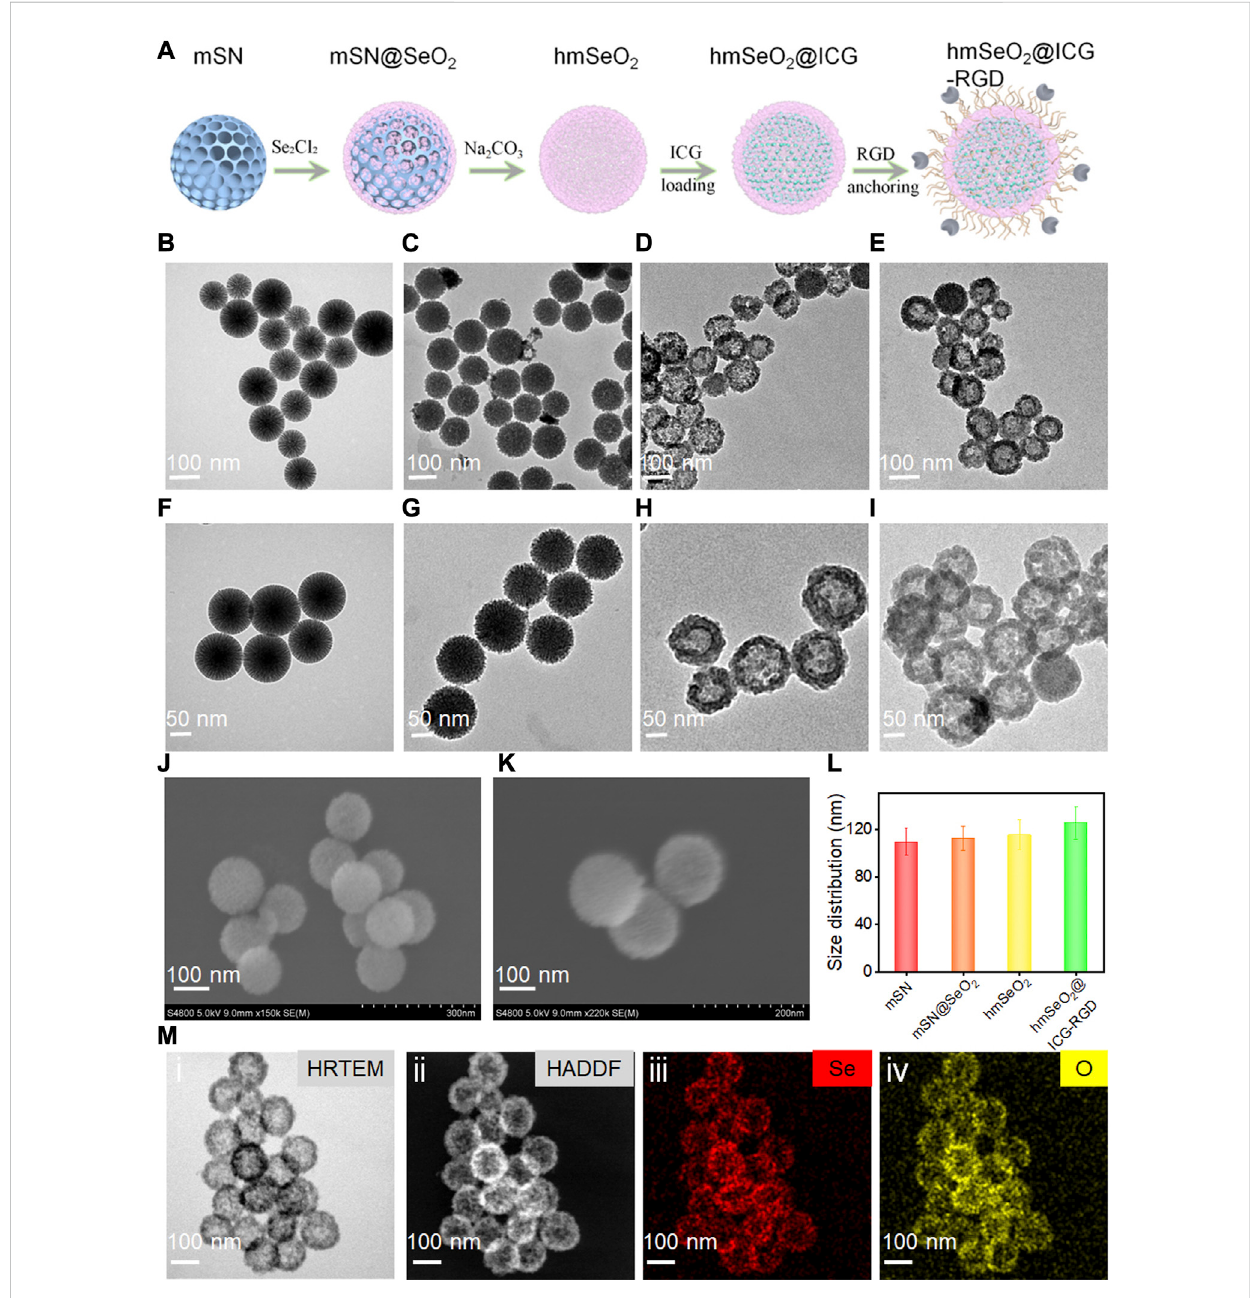
FIGURE 2 (A) Schematic illustrating step-by-step hmSeO 2 @ICG-RGD construction. (B – I) Large-scale and magni fi ed TEM images of mSN (B, F) , mSN@SeO 2 (C, G) , hmSeO 2 (D, H) , and hmSeO 2 @ICG-RGD (E, I) . SEM images of hmSeO 2 and hmSeO 2 @ICG-RGD (J, K) . (L) Size distributions of mSN, mSN@SeO 2 ,